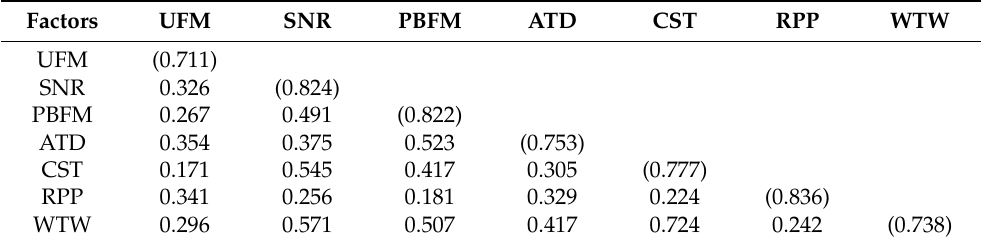
Table 3. Correlation and test of discriminant